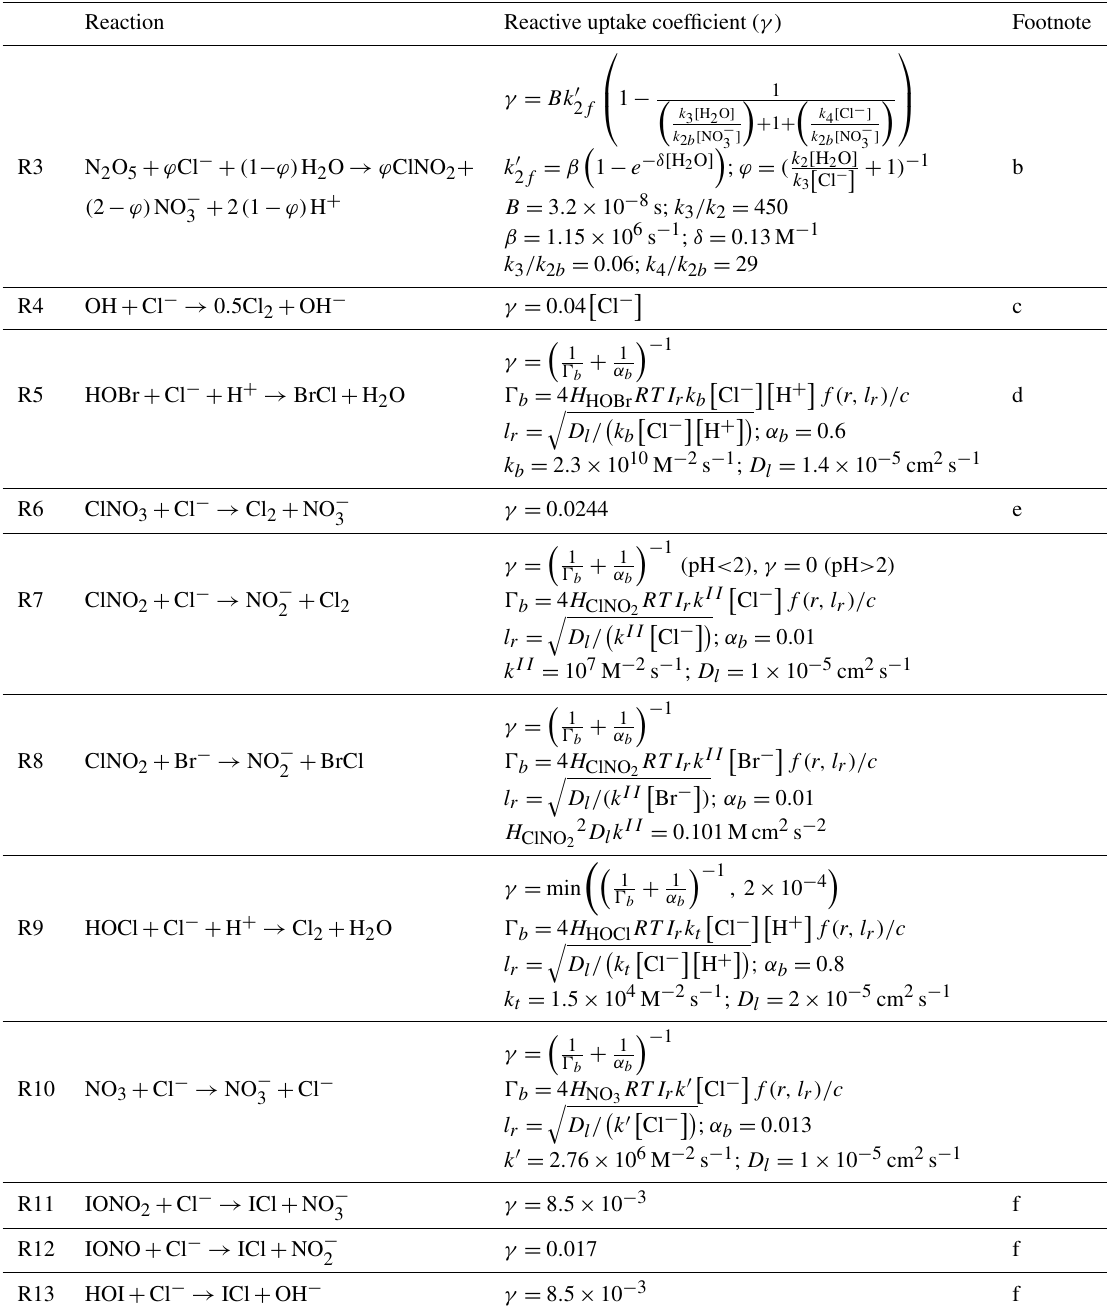
Table 2. Heterogeneous reactions of Cl − and reactive uptake coefficients ( γ ) a .